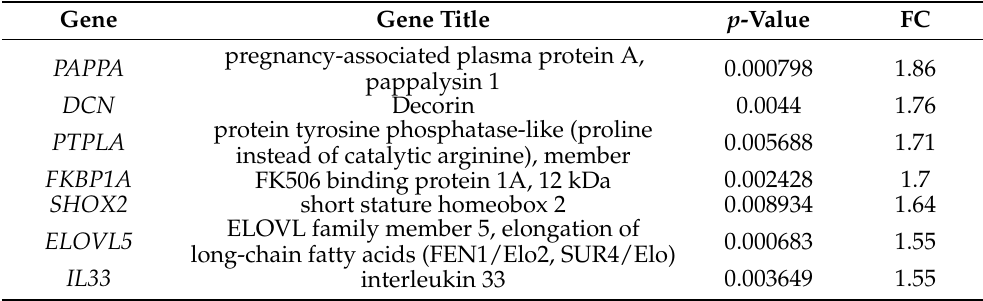
Table 2. Significantly altered probes in PCOS patients with history of OHSS as compared to no history of OHSS ( p -value < 0.01 and >1.5-fold